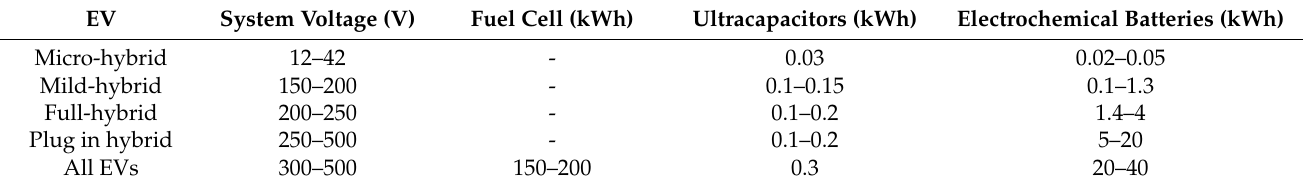
Table 1. Energy storage specifications for EVs [15,16].